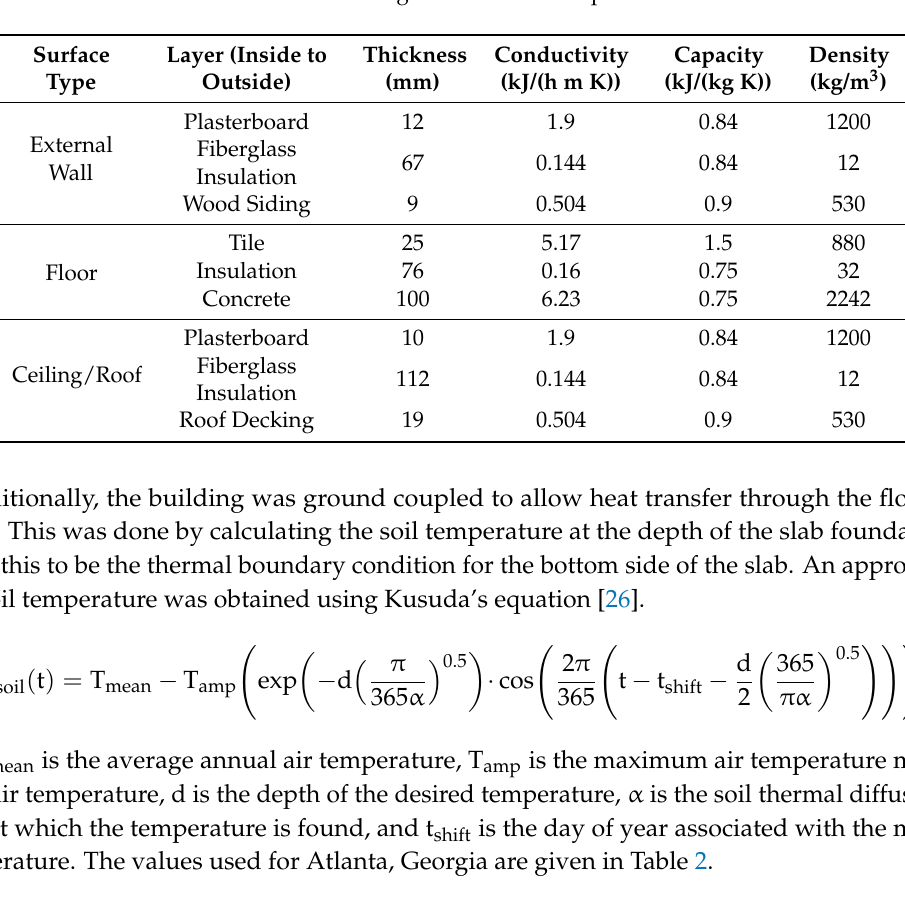
Table 1. Building Materials and Properties.